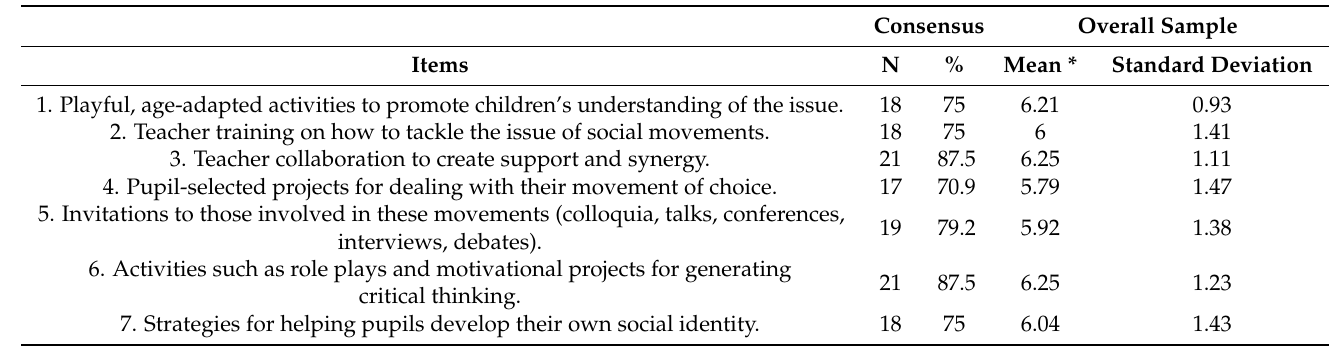
Table 1. Category A. Strategies for helping primary schoolteachers tackle the issue of social move- ments.